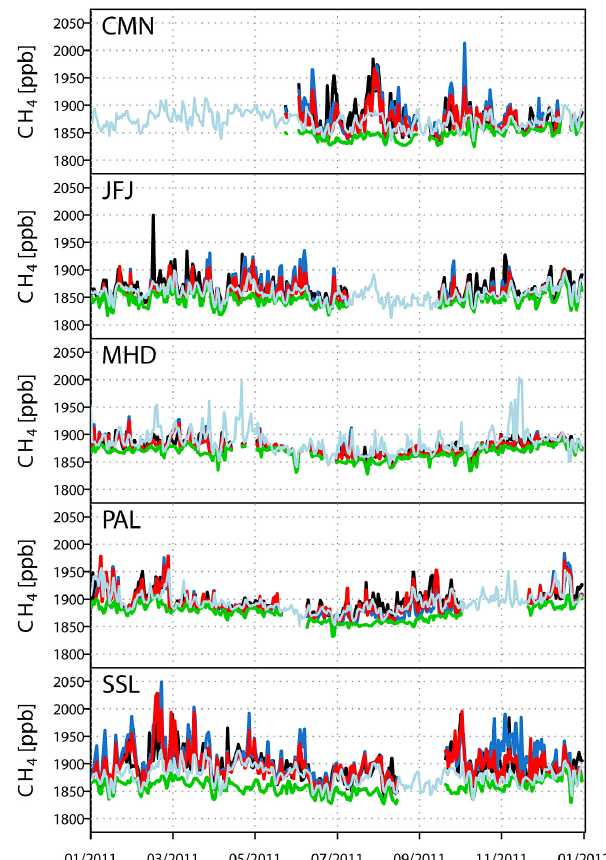
Figure 3. CH 4 mole fractions (ppb) as observed (black) and simu- lated from the prior (blue) and posterior models (red). Also shown is the background CH 4 mole fraction (green) and CH 4 calculated by the TM5 Eulerian model (light